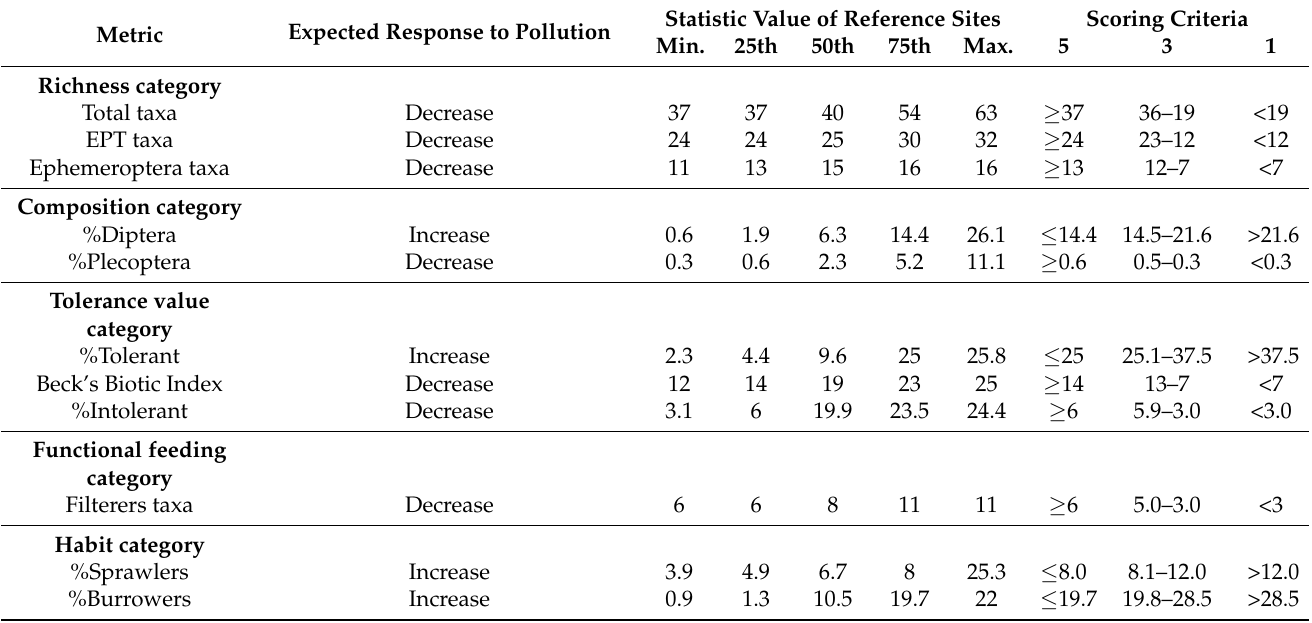
Table 6. Score thresholds for each of the 11 core metrics integrated in Lao MMI.